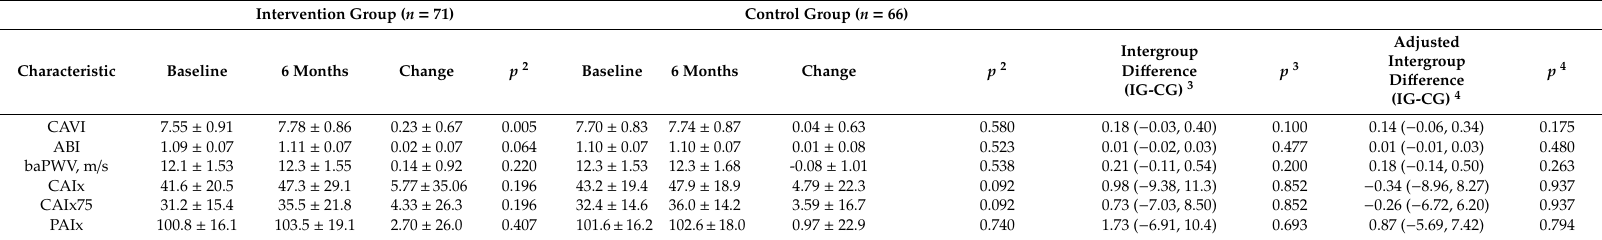
Table 4. Arterial sti ff ness parameters and vascular function in postmenopausal women participants 1